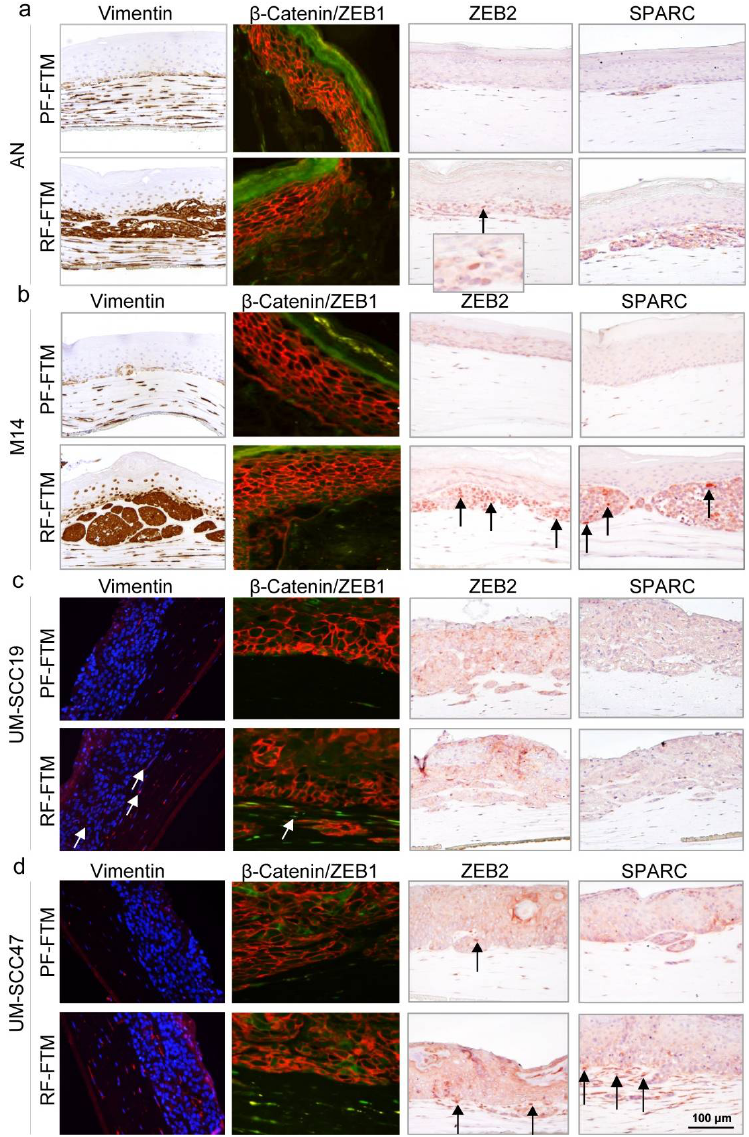
Figure 5. IHC and IF staining for EMT-related markers in melanoma or HNSCC FTMs. Vimentin, β-catenin/ZEB1, ZEB2 and SPARC were stained in PF-FTMs and RF-FTMs with ( a ) AN, ( b ) M14, ( c ) UM-SCC19 and ( d ) UM-SCC47 epidermis. Arrows indicate the expression of these biomarkers. Data was obtained from three independent experiments.